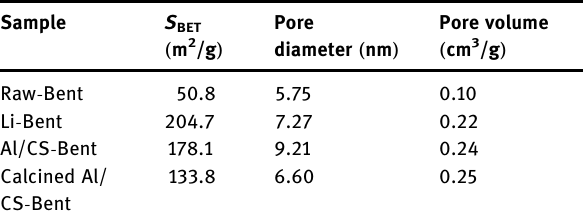
Table 1: Pore structure characteristics obtained from conventional analysis of nitrogen